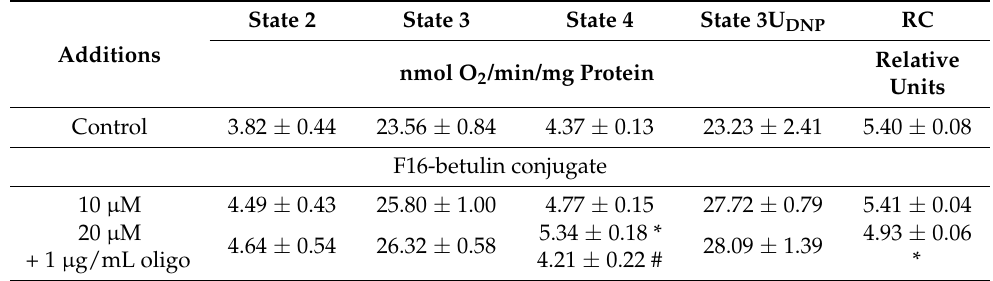
Table 1. Effect of F16-betulin on oxygen consumption by rat liver mitochondria fueled by gluta- mate plus malate.